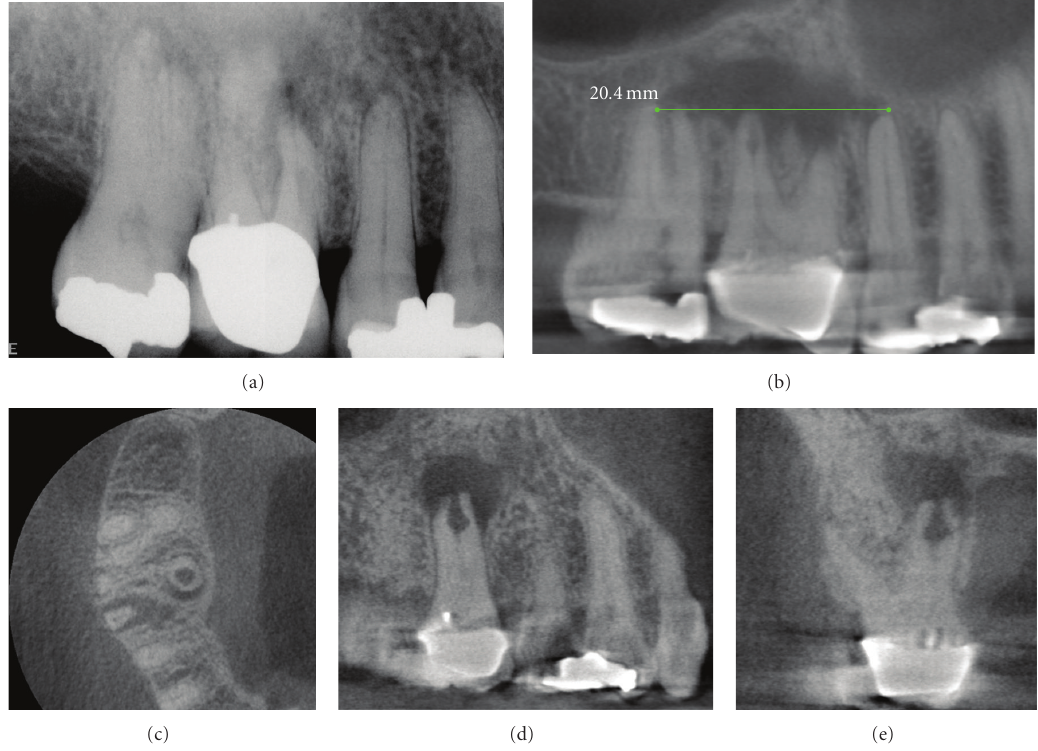
Figure 16: Because two-dimensional imaging su ff ers from superimposition of anatomic structures, determination of the extent and pathogenesis of periradicular lesions can present diagnostic challenges. This is particularly true of the maxillary posterior region, where the roots of teeth overlap and anatomic structures form complex patterns. A patient presented with discomfort in the maxillary right that extended from the nose to the ear. On clinical examination buccal swelling and induration were present—all teeth tested vital except the maxillary right first molar. A periapical radiograph (a) demonstrated areas of low density at the apices of the maxillary right first and second molars. CBCT images ((b) 10 mm curved planar, (c) axial, (d) sagittal, (e) cross-sectional) however demonstrated a much more extensive (21.4mm maximum length) unilocular lesion, centered on the palatal root of the maxillary first molar, and extending anteriorly to the second bicuspid and posteriorly to the second molar. Also note the large internal resorptive lesion at the mid-palatal root of the maxillary first molar, not visible on the periapical radiograph. Biopsy confirmed the lesion to be a periapical granuloma with abscess formation.